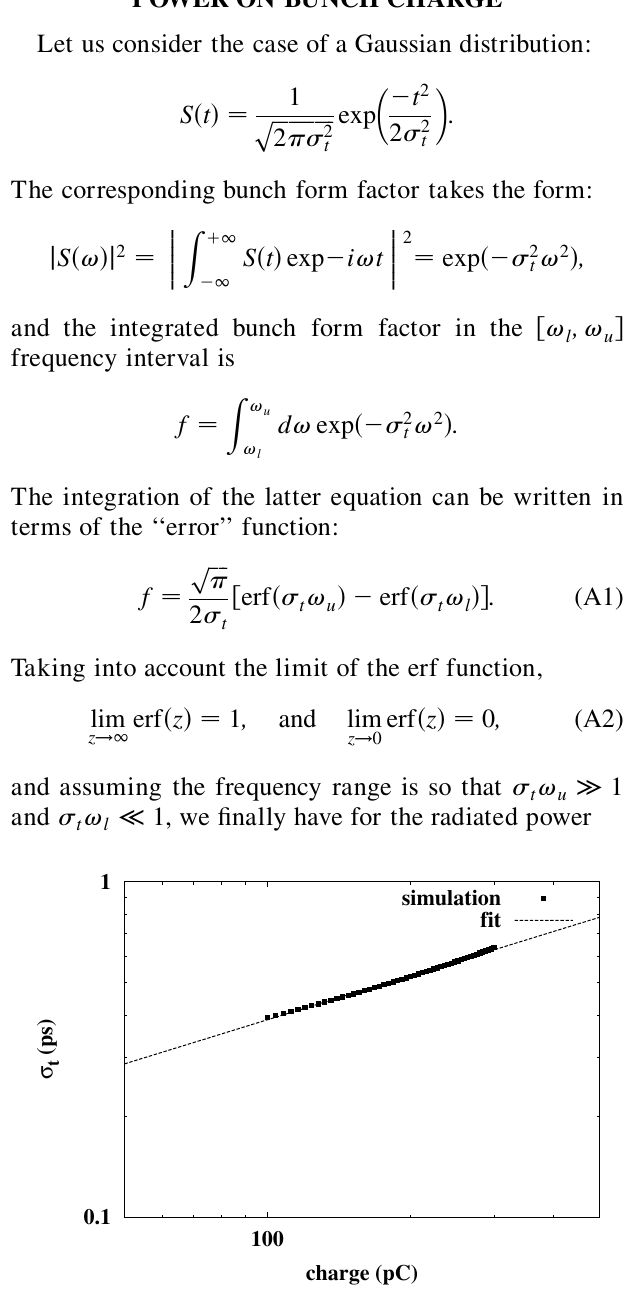
FIG. 9. Simulated dependence of bunch length versus charge. The circles are simulation results; the line is a fit to the simulation using a (cid:15) (cid:13) Q (cid:12) law; the result gives (cid:12) (cid:3) 0 : 437 (cid:14) 0 : 007